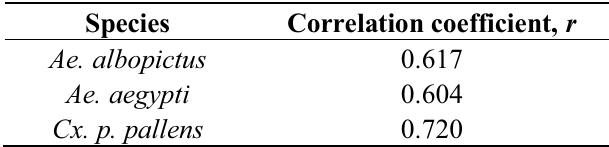
and IC values of 10 selected 50 50